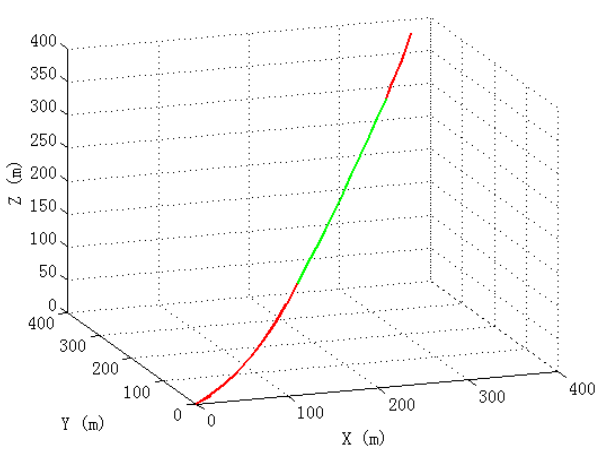
Figure 21. Configuration of the multicomponent mooring line.